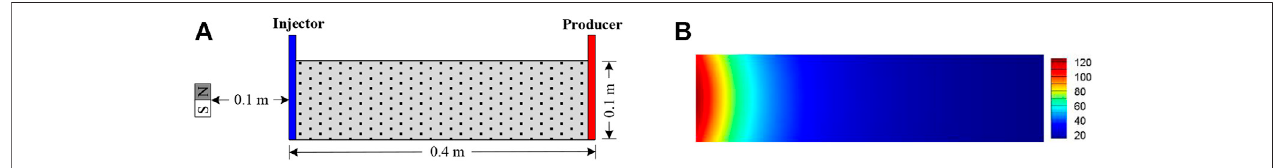
FIGURE 3 | Simple porous media model. (A) Model geometry; (B) Distribution of background magnetic fl ux density norm |B| in units of Gs.